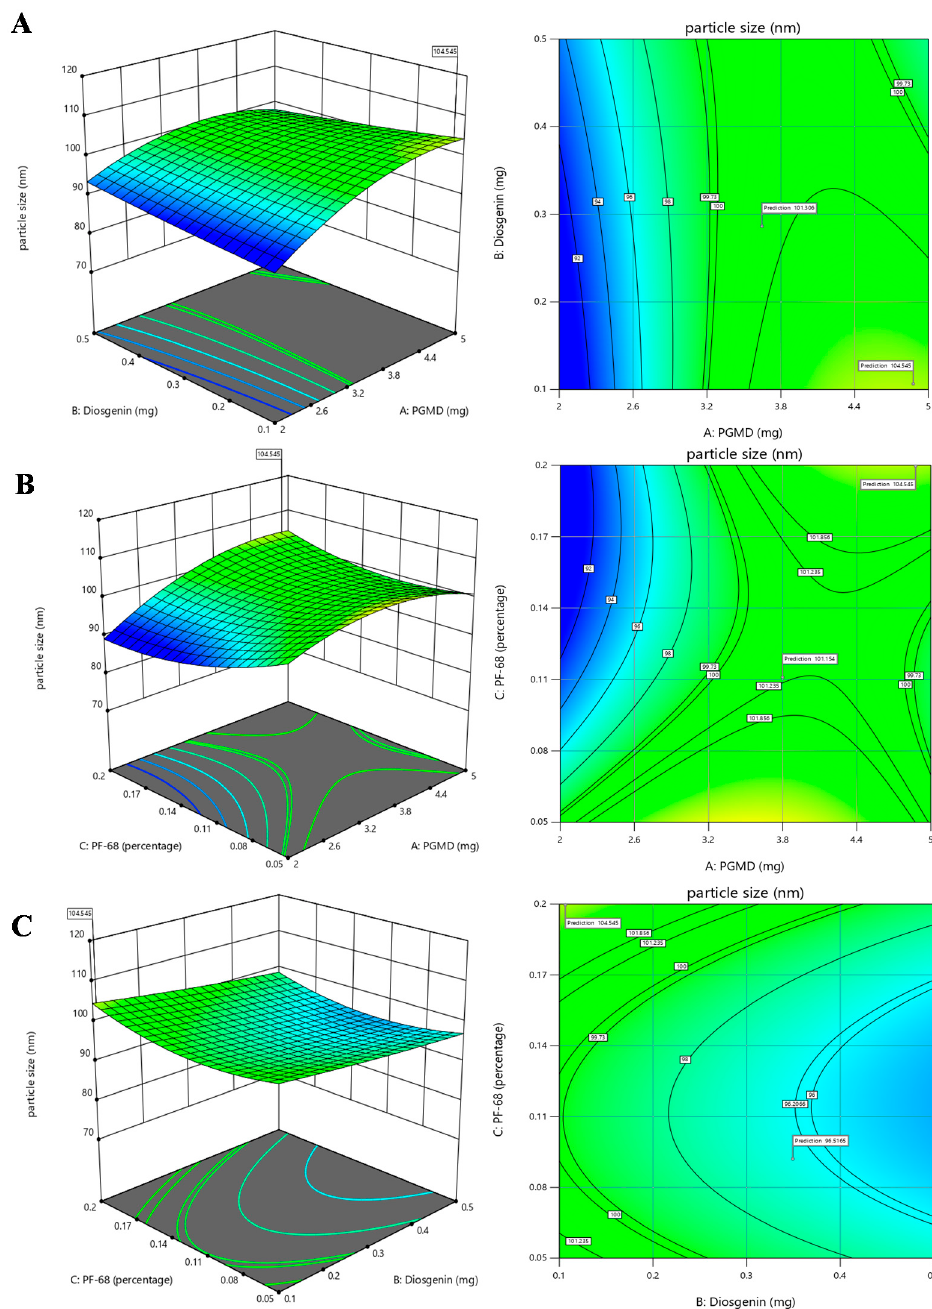
Figure 2. 3D response surface plots and 2D contour plots depicting the effects of factors: PGMD, Diosgenin and Pf-68 concentrations on particle size, ( A ) PGMD vs. Diosgenin; ( B ) PGMD vs. PF-68 and ( C ) Diosgenin vs. PF-68.